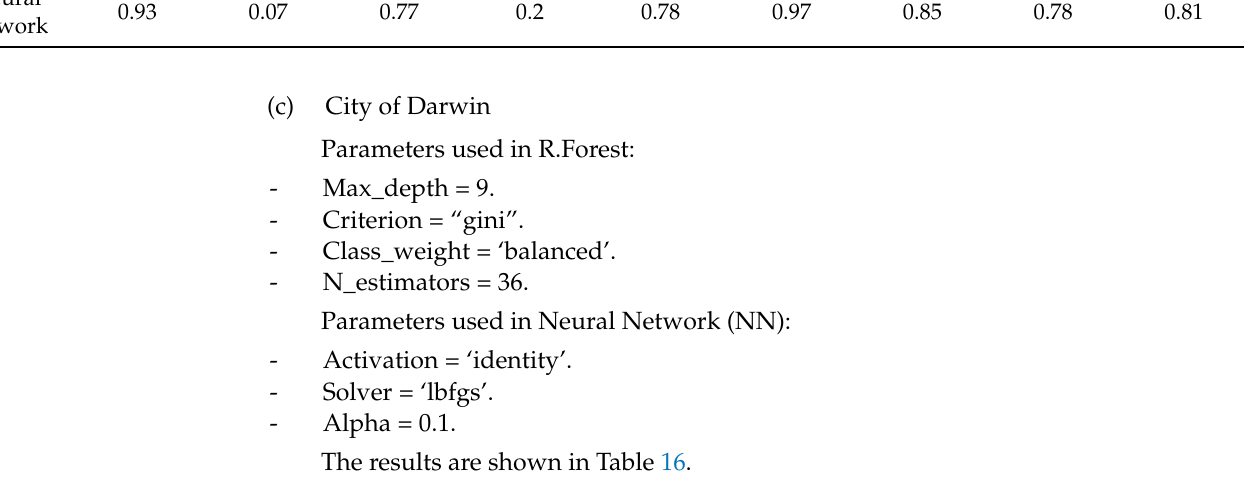
Table 16. Models for city of